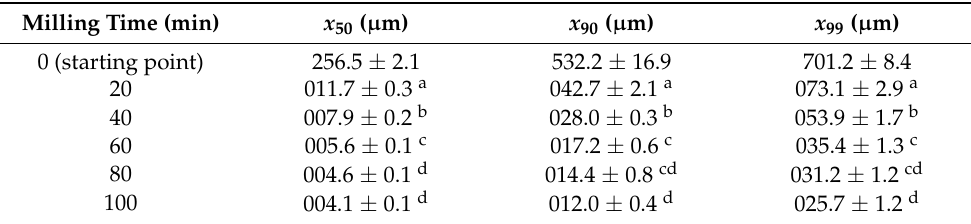
Mean values ( ± half deviation range) in a column with different letters differ significantly ( p <